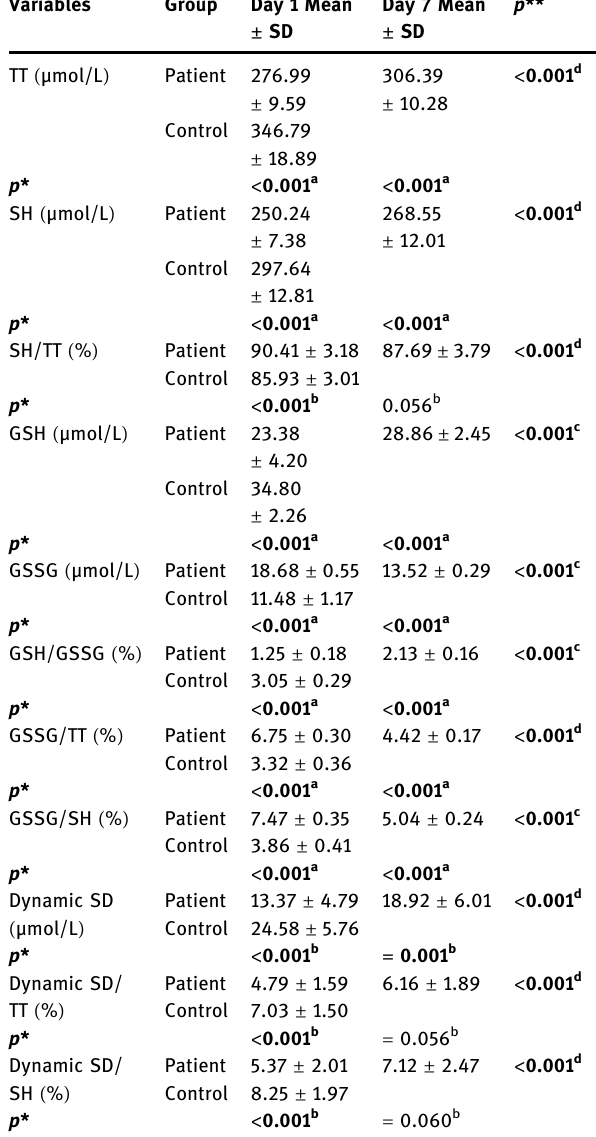
Table 3: Comparison of the mean measurement values on day 1 and day 7 of the patient group and the day 1 measurement values of the control